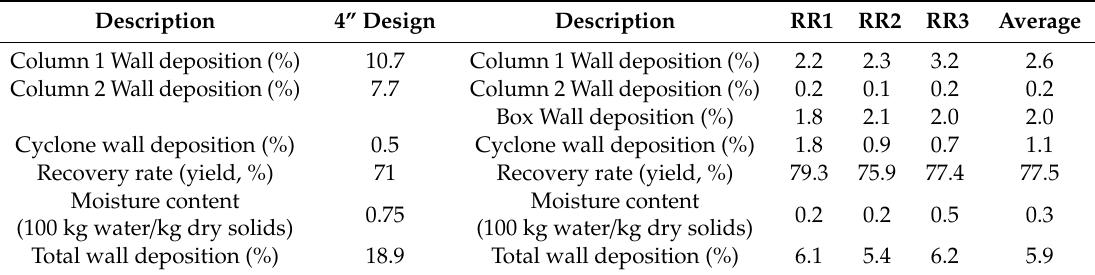
Table 10. Overall deposition percentages for a 30 wt% solids concentration feed at an inlet air temperature of 170 ◦ C (RR1 = run 1, RR2 = run 2, RR3 = run 3). The standard error for the